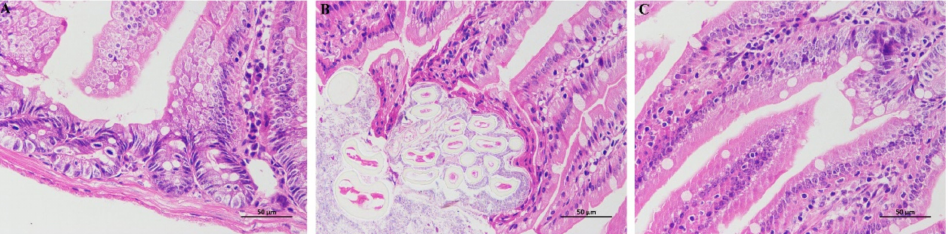
Figure 6. Section analysis of small intestine. ( A ) Small intestine section of BG group; ( B ) Small intestine section of MG group; ( C ) Small intestine section of DG